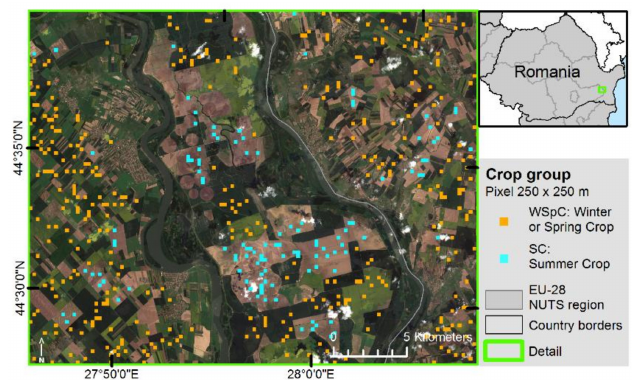
Figure 4. Details of a single year (2017) for a subset of the Romanian validation site (RO), showing the real size of pure pixels (250 × 250 m), overlaid on a Sentintel-2 RGB maximum value composite for May 2017.